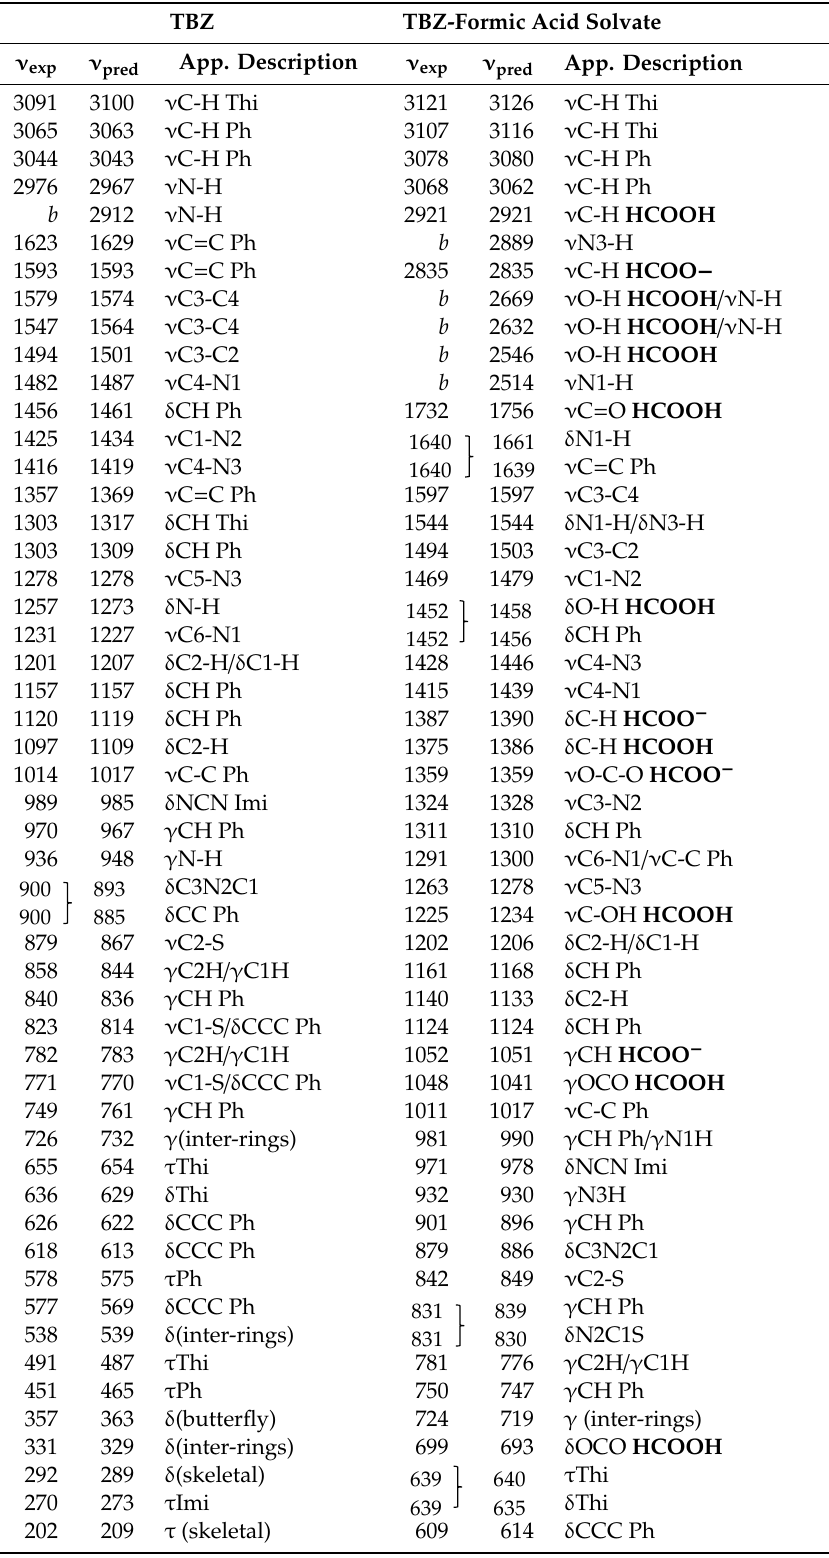
Table 6. Experimental and calculated Raman frequencies for TBZ and TBZ-formic acid solvate crystals with proposed assignments a .